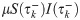
One single-period diffusion process through τk to τk+1.At update time τk, the impulsive intensity of μS(τk-)I(τk-) indicates the newly recruited audience, while removed population βI(τk-) is the audience stopped watching, which is only counted at every update time. During non-update periods, external influence αS(t) and interpersonal spreading λS(t)I(t) occur in every time unit. A concave feverish function is used to fit the imbalance of the on-demand streaming distribution.